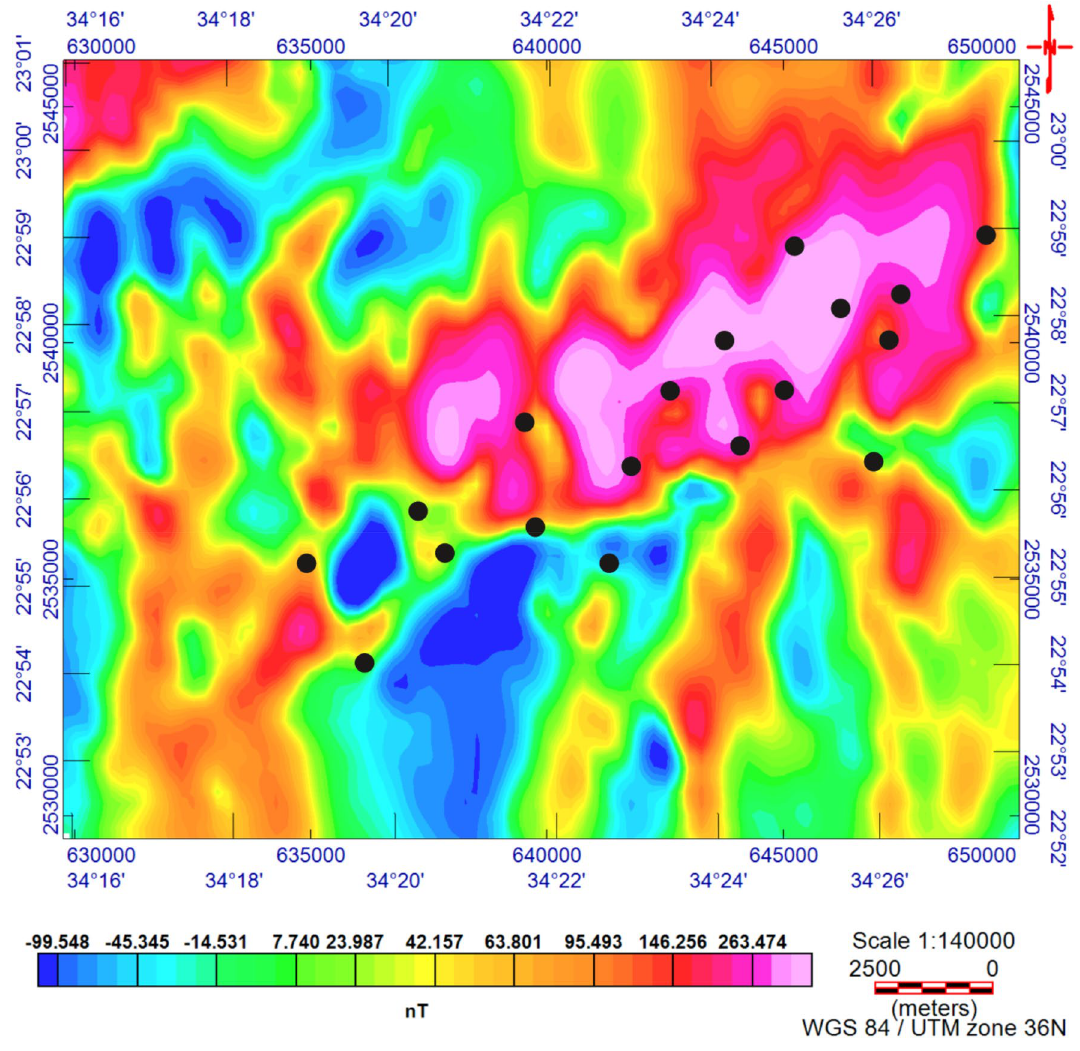
Figure 4. The RTP map of the Study area with rock